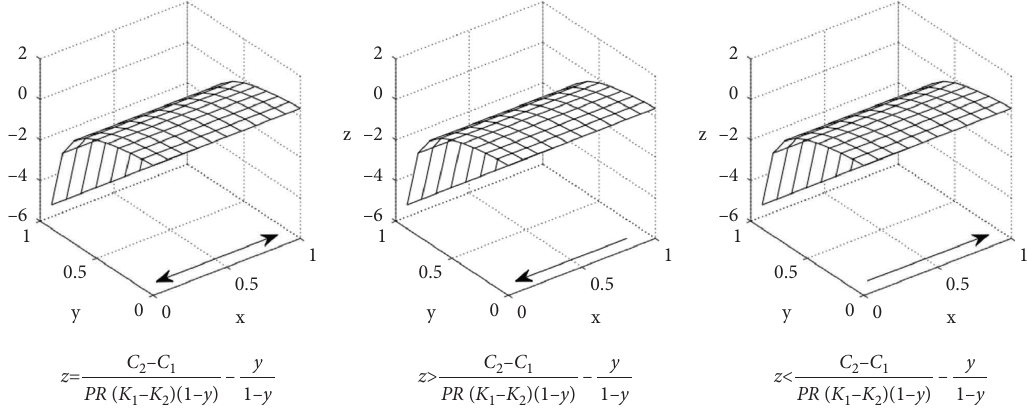
Figure 4: Te evolutionary process of agricultural producers.